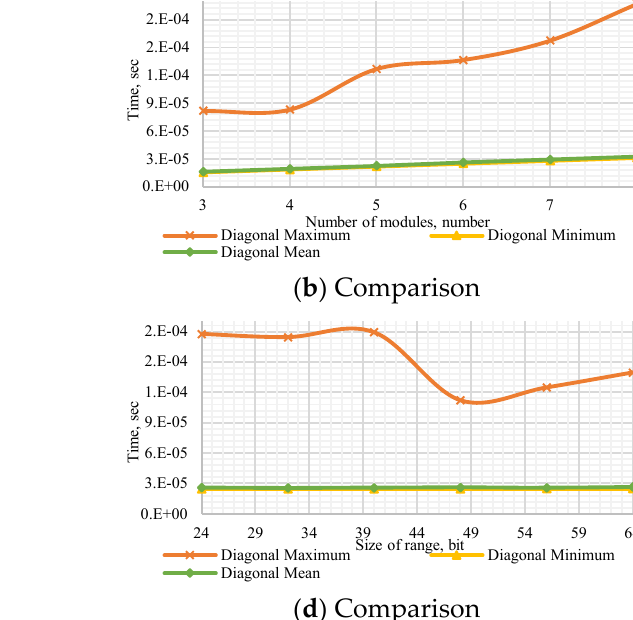
Figure A3. Performance of the Approximate Method to ( a ) determine the number’s sign with a dynamic number of modules p , ( b ) compare the dynamic number of modules p , ( c ) determine the number’s sign with a dynamic bit width, and ( d ) compare numbers with dynamic bit width.